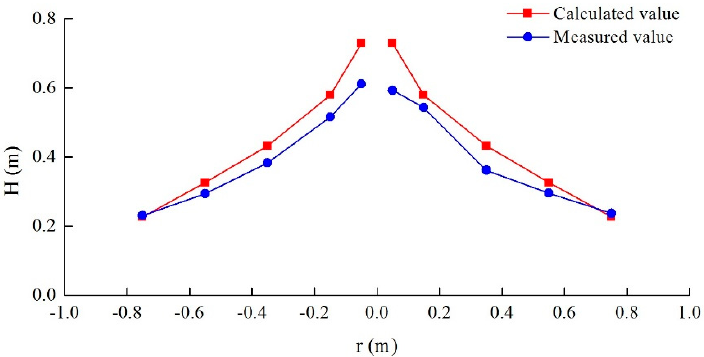
Figure 8. Comparison of the calculated value and the measured value.